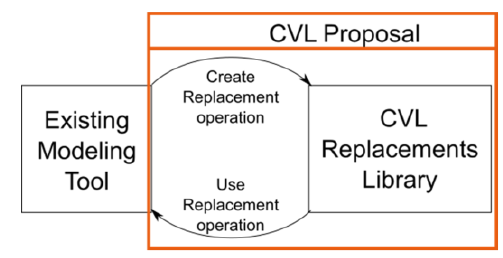
Figure 5. Modeling Tool augmented with CVL